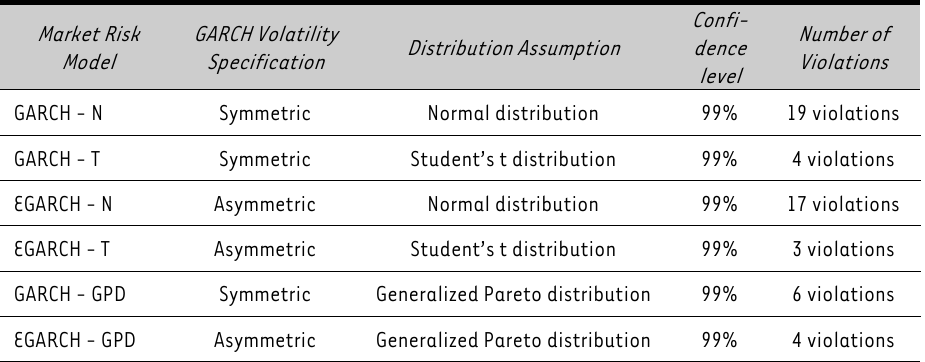
Model stress testing results Market